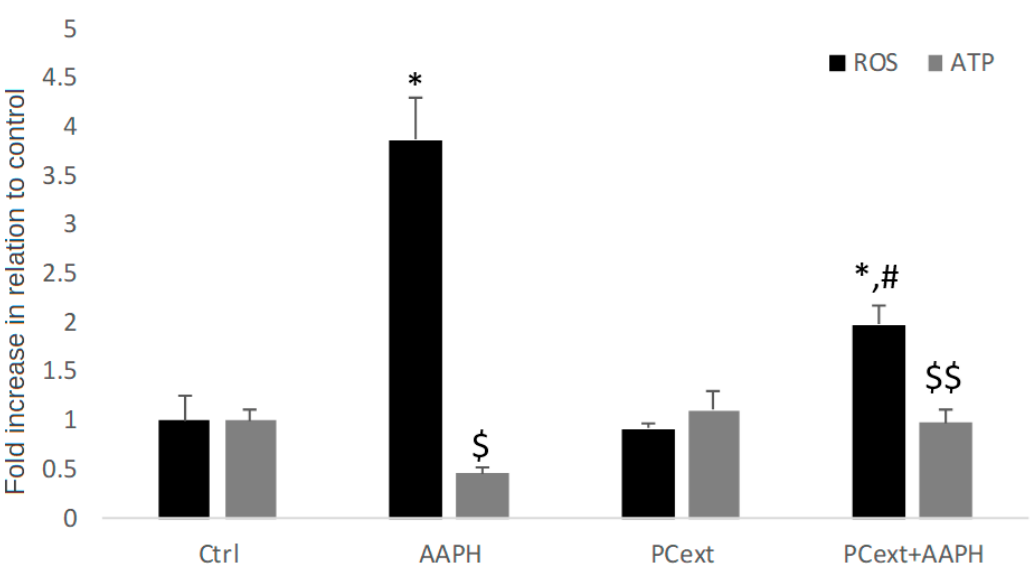
Figure 2. Intracellular reactive oxygen species (ROS) and ATP levels in human dermal fibroblasts (HDFa), showing Crtl (Control cells), treatment with crude pechiche extract (PCext), treatment with the stressor AAPH (AAPH) and pretreatment with crude pechiche extract and then stressed with AAPH (PCext-AAPH). Results are reported as mean ± SD of three experiments. * p ≤ 0.05, significant differences compared to control and # p ≤ 0.05, significant differences between AAPH and PCext-AAPH groups for intracellular ROS levels; $ p ≤ 0.05, significant differences compared to control and $$ p ≤ 0.05, significant differences between AAPH and PCext-AAPH groups for ATP levels.